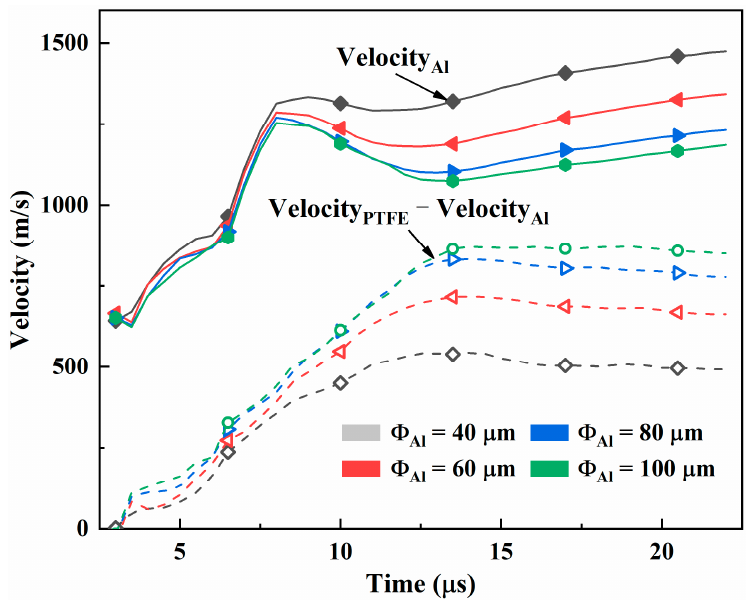
Figure 14. Velocity–time profiles of Al and PTFE-Al. Note: All the average velocities at each moment only calculate material with velocities higher than 0 m/s.